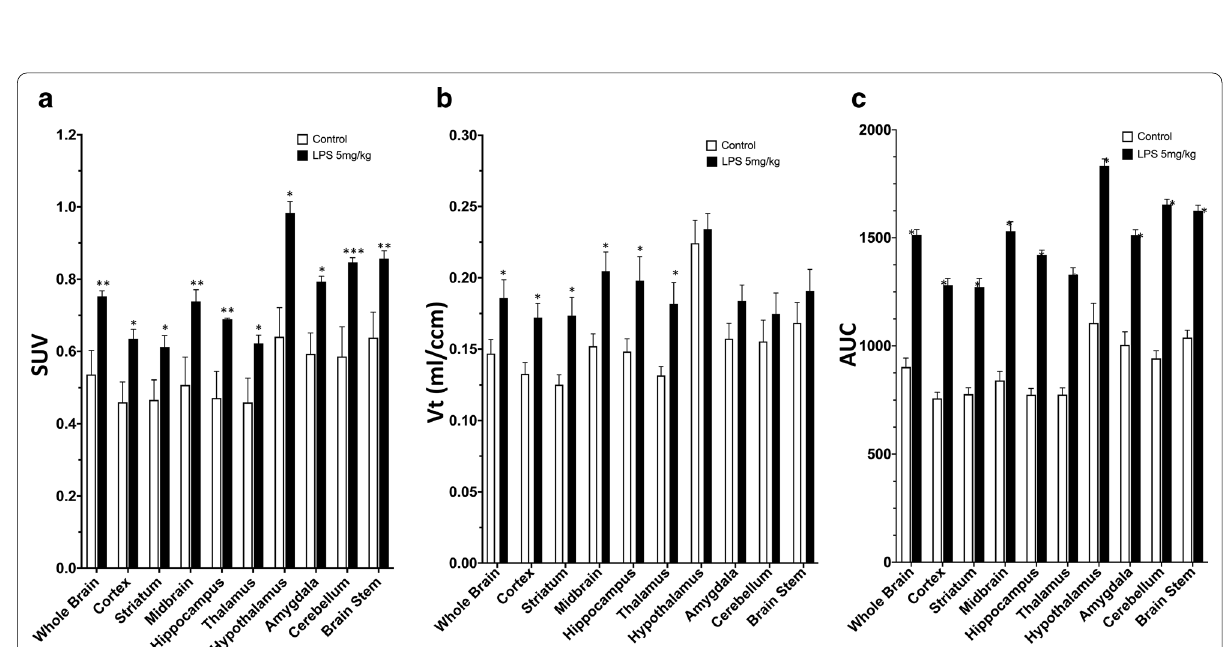
Fig. 5 Pharmacokinetics of [ 18 F]FEPPA after i.v. administration. Quantitative analysis of radioactivity in control mice and LPS‑injected mice (5 mg/ kg). a SUV, b VT, and c AUC. Data are mean SEM of 6–8 mice per group; * p < 0.05, ** p < ±